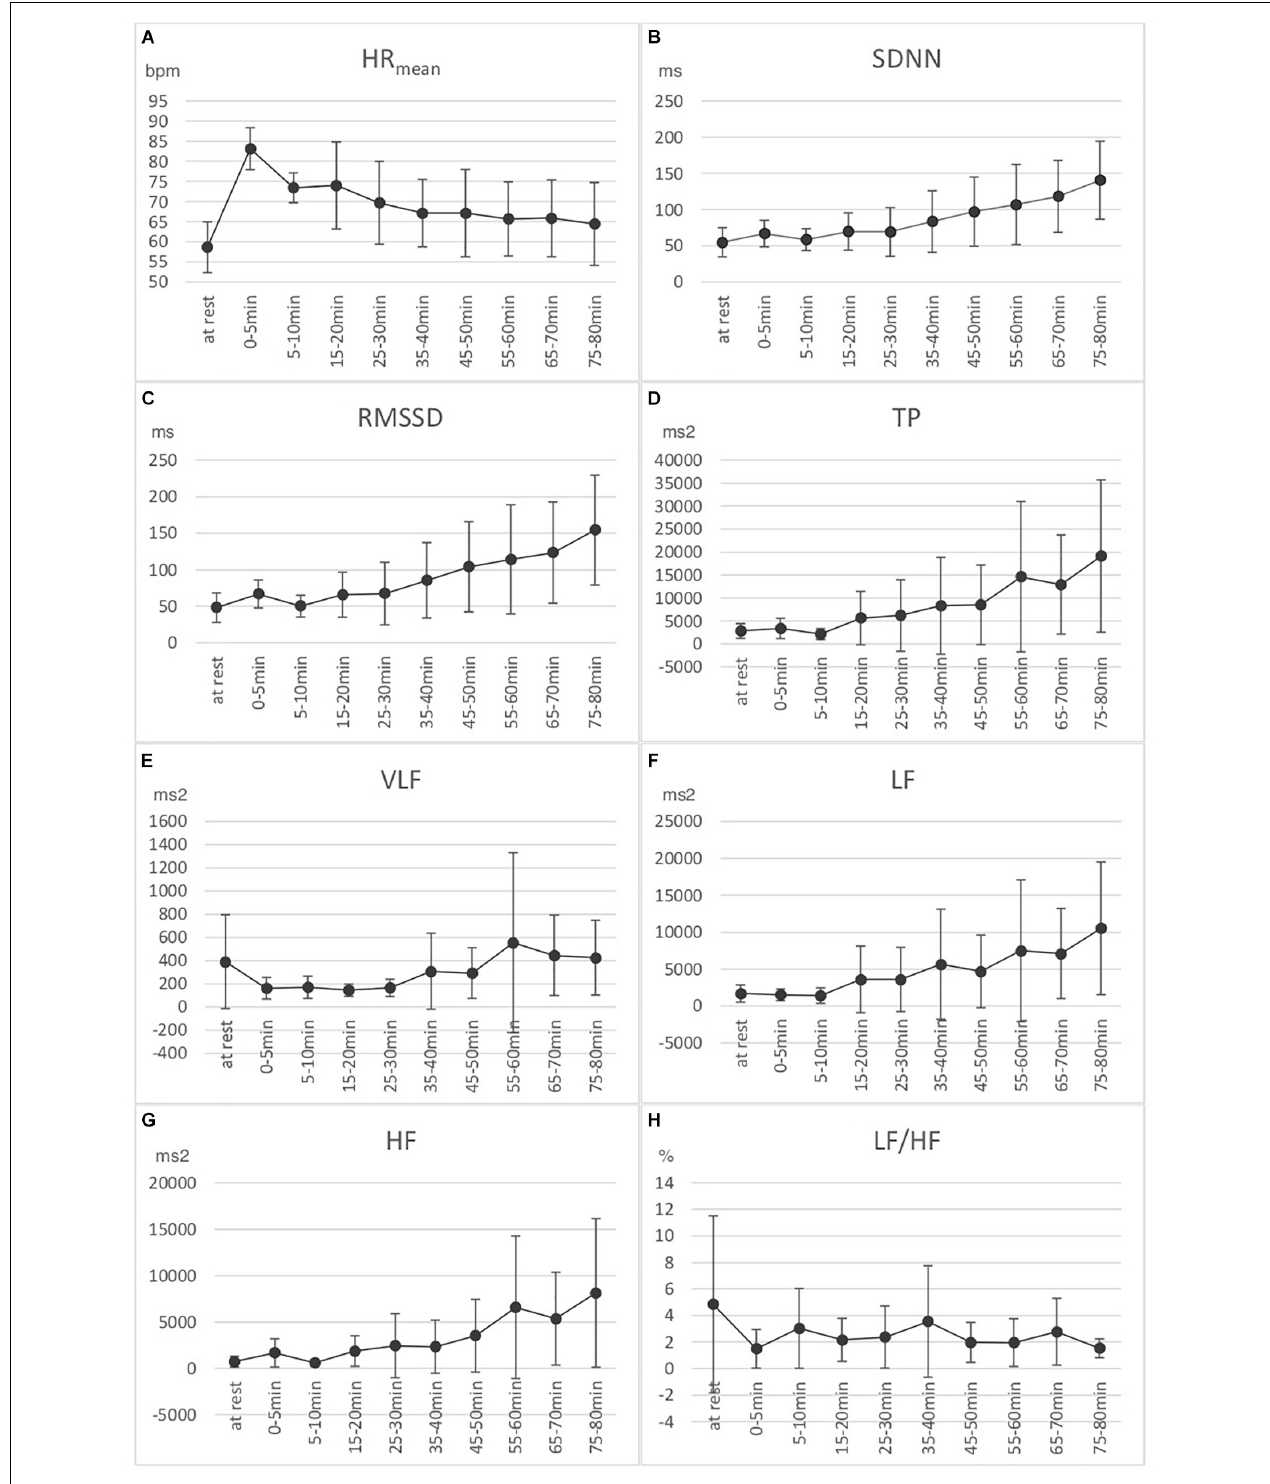
FIGURE 1 | Eight HRV measures: three time-domain measures [ (A) Mean heart rate (HR mean ), (B) Standard deviation of NN intervals (SDNN), and (C) Root mean square of successive RR interval differences (RMSSD)], and five frequency-domain measures [ (D) Absolute power of the very low frequency band (VLF power), (E) Absolute power of the low frequency band (LF), (F) Absolute power of the high frequency band (HF), (G) Absolute total power (TP), and (H) Ratio of LF to HF power (LF/HF)]. Measures are presented at rest ( n = 22), 0–5 min ( n = 11), 5–10 min ( n = 11), 15–20 min ( n = 7), 25–30 min ( n = 7), 35–40 min ( n = 7), 45–50 min ( n = 7), 55–60 min ( n = 7), 65–70 min ( n = 7), and 75–80 min ( n = 7). Means and standard errors shown.